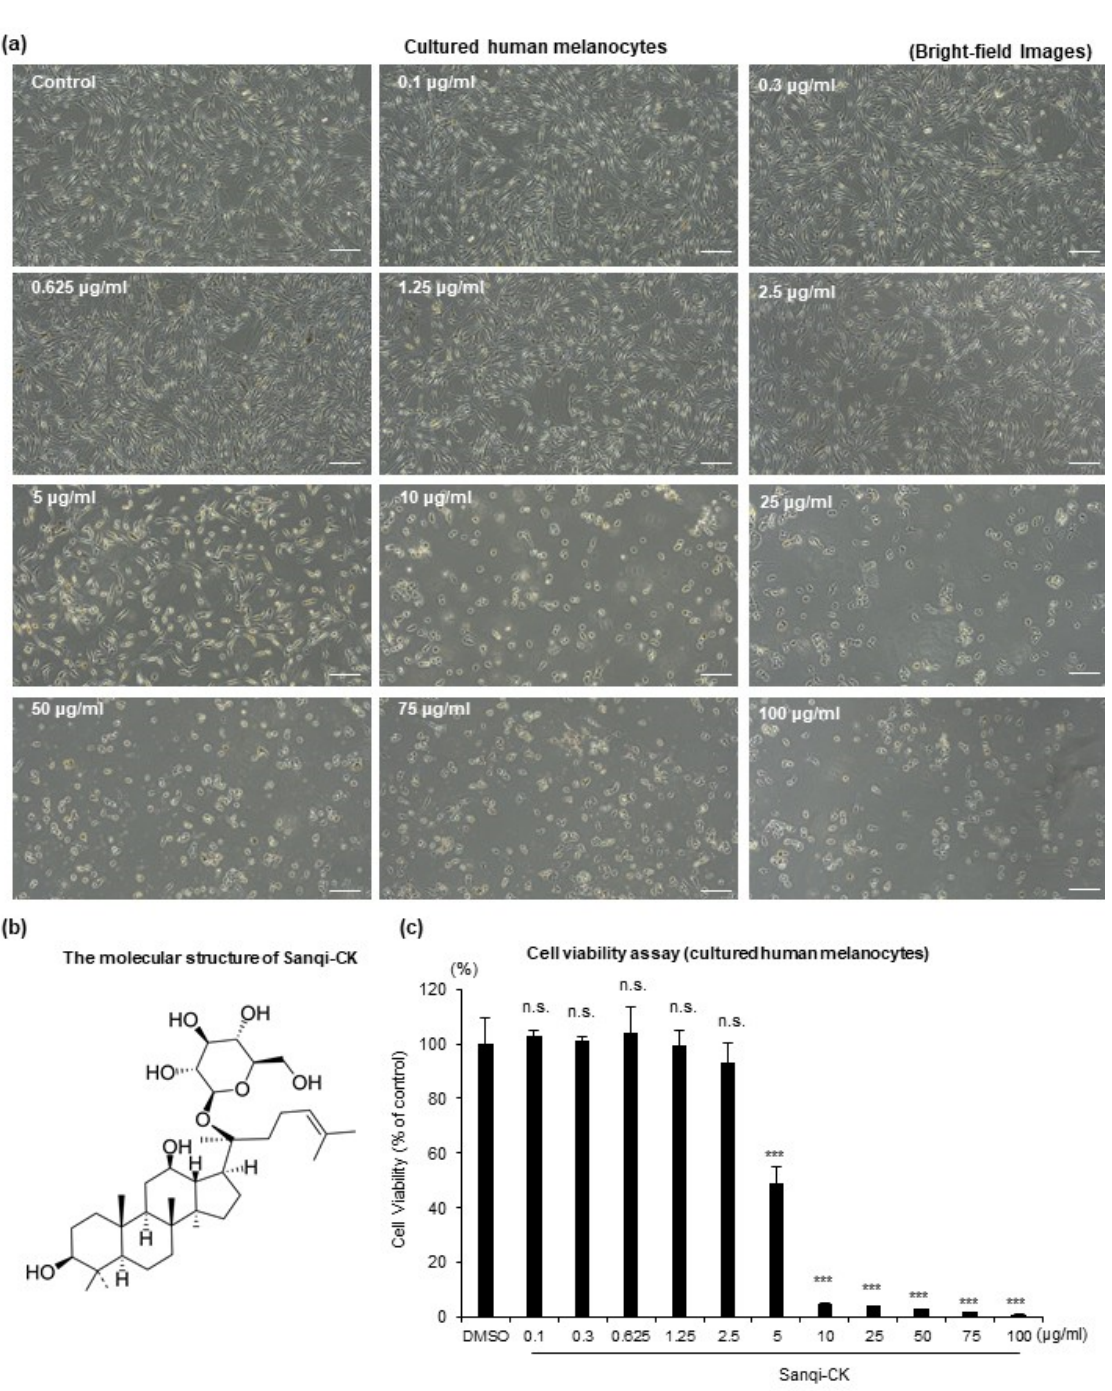
Figure 1. Cytotoxicity analyses by morphologic examination and MTT assay. Cultured human primary epidermal melanocytes (HEMn-MPs) were treated with increasing concentrations of Sanqi-CK (0.1–100 µ g/mL) for 24 h. ( a ) Changes in melanocyte morphology were observed via bright-field microscopy; white bar, 50 µ m. ( b ) Molecular structure of Sanqi-CK. ( c ) Cell viability was assessed by MTT assay. Data in ( c ) represent the results of three independent experiments and are shown as mean ± SD. n.s., no significant difference; *** p < 0.01; compared with control (DMSO) according to one-way analysis of variance (ANOVA) followed by Dunnett’s